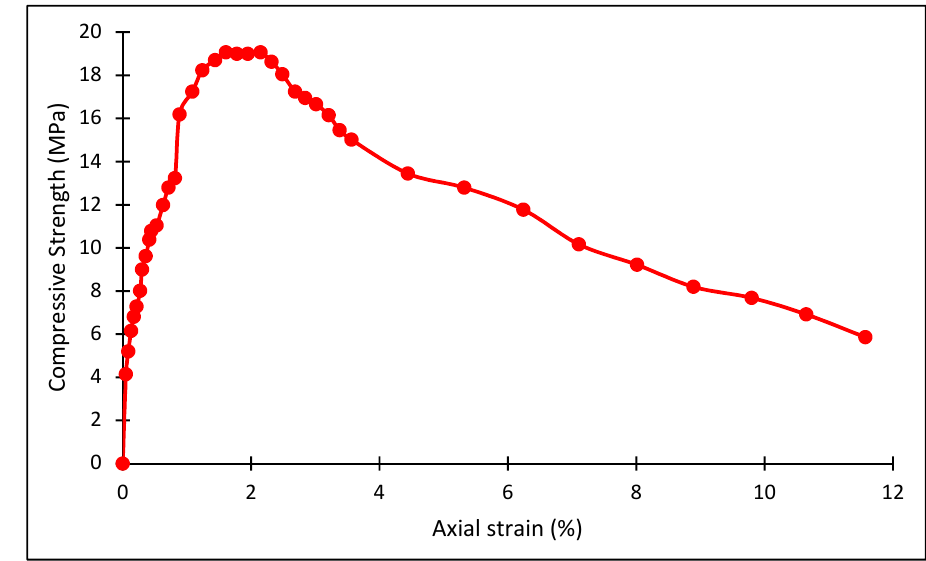
Figure 24. Rheology curves of mixture VII at different times after mixing.